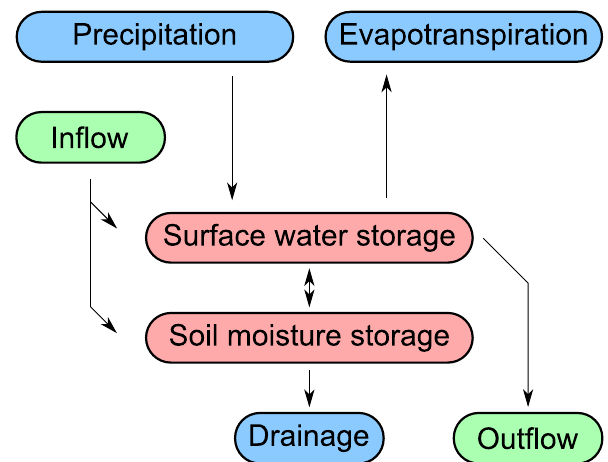
Fig. 3. Wetland water balance as simulated by the DWES. The green boxes indicate horizontal water flows, the blue ones indicate vertical water flows, and the red ones indicate water storages. Please note that horizontal inflow can fill the soil moisture storage as well as the surface water storage of the wetlands. However, horizontal outflow is only generated during periods when surface water exists in the respective